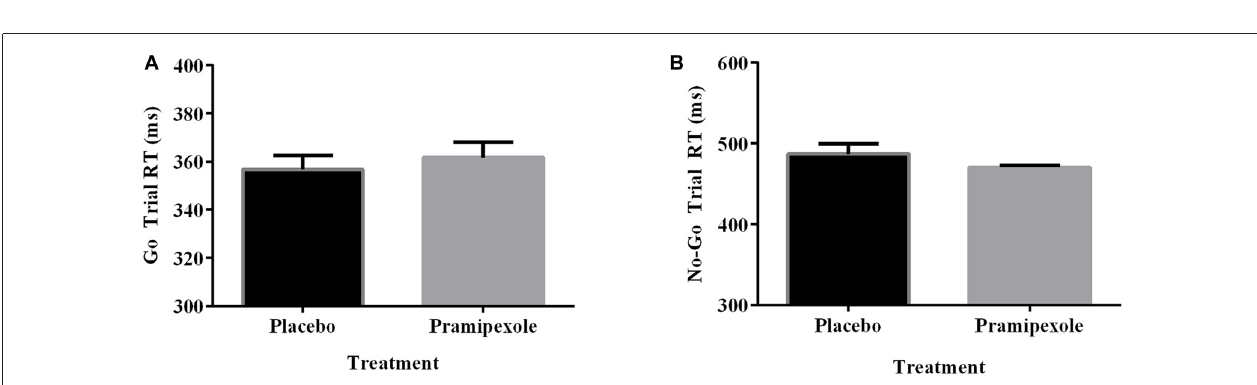
FIGURE 2 | Effect of treatment with either standard placebo or 0.5 mg of pramipexole on Go trial timeouts and No-go trial errors ( N = 20). Both variables were analyzed with two-tailed t -tests. Data represent mean ± SEM. (A) Participants treated with pramipexole timed out in a significantly greater number of Go trials compared to participants treated with placebo ( ∗ p < 0.05). (B) No significant difference was found for number of No-go trial errors between the placebo- and pramipexole-treated participants ( p > 0.05).